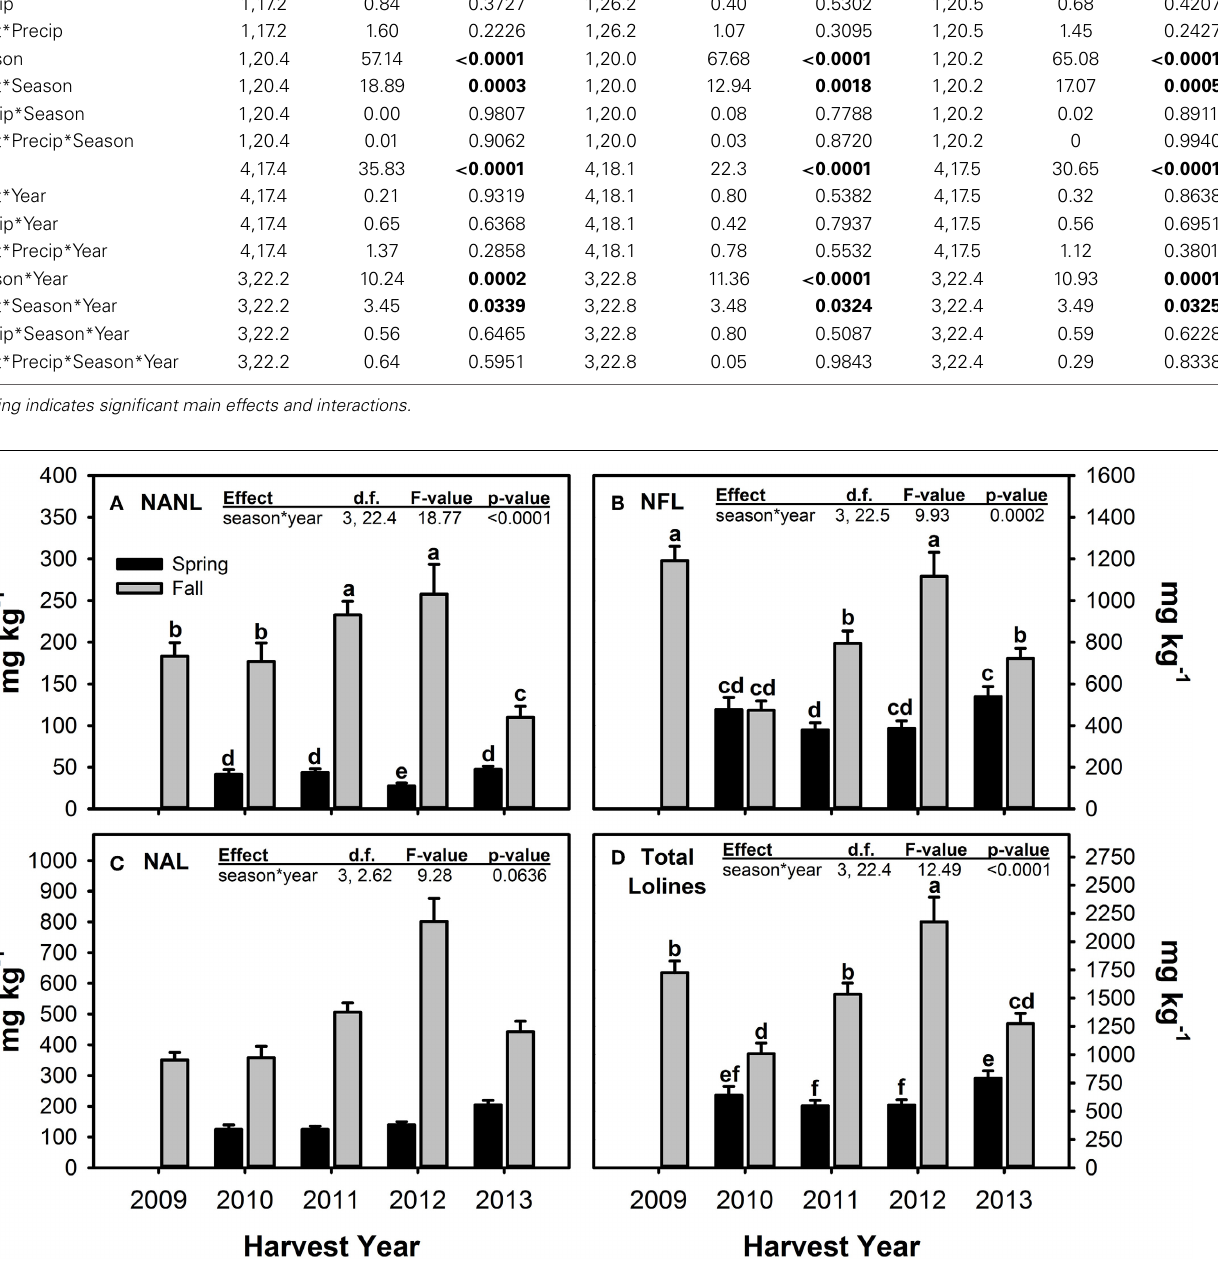
across all climate treatments. Spring 2009 is missing due to lab error. For loline alkaloids with a significant season × year interaction term, different letters indicate significant differences across all seasons and years of the